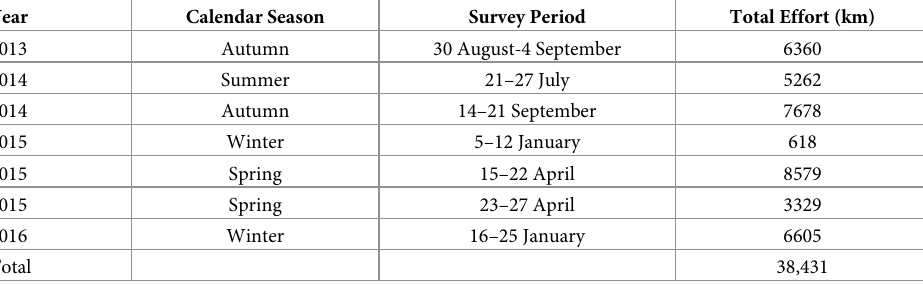
Table 1. Summary of aerial